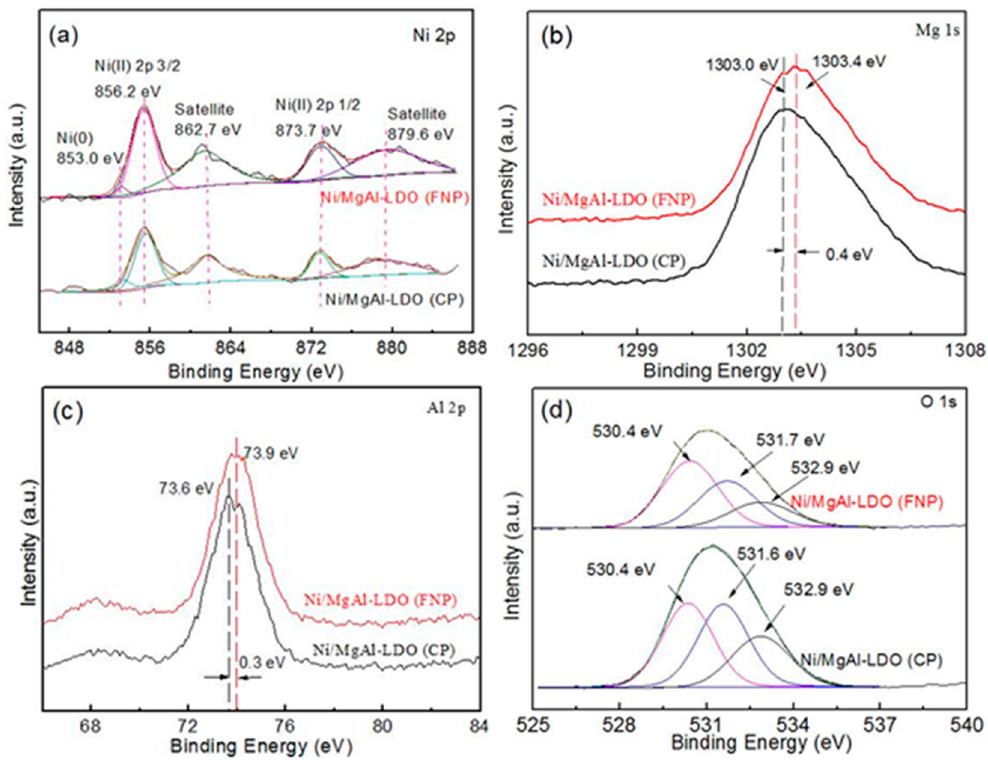
Figure 8. XPS spectra of the as-obtained Ni/MgAl-LDO (CP) and Ni/MgAl-LDO (FNP): ( a ) Ni, ( b ) Mg, ( c ) Al, and ( d ) O.